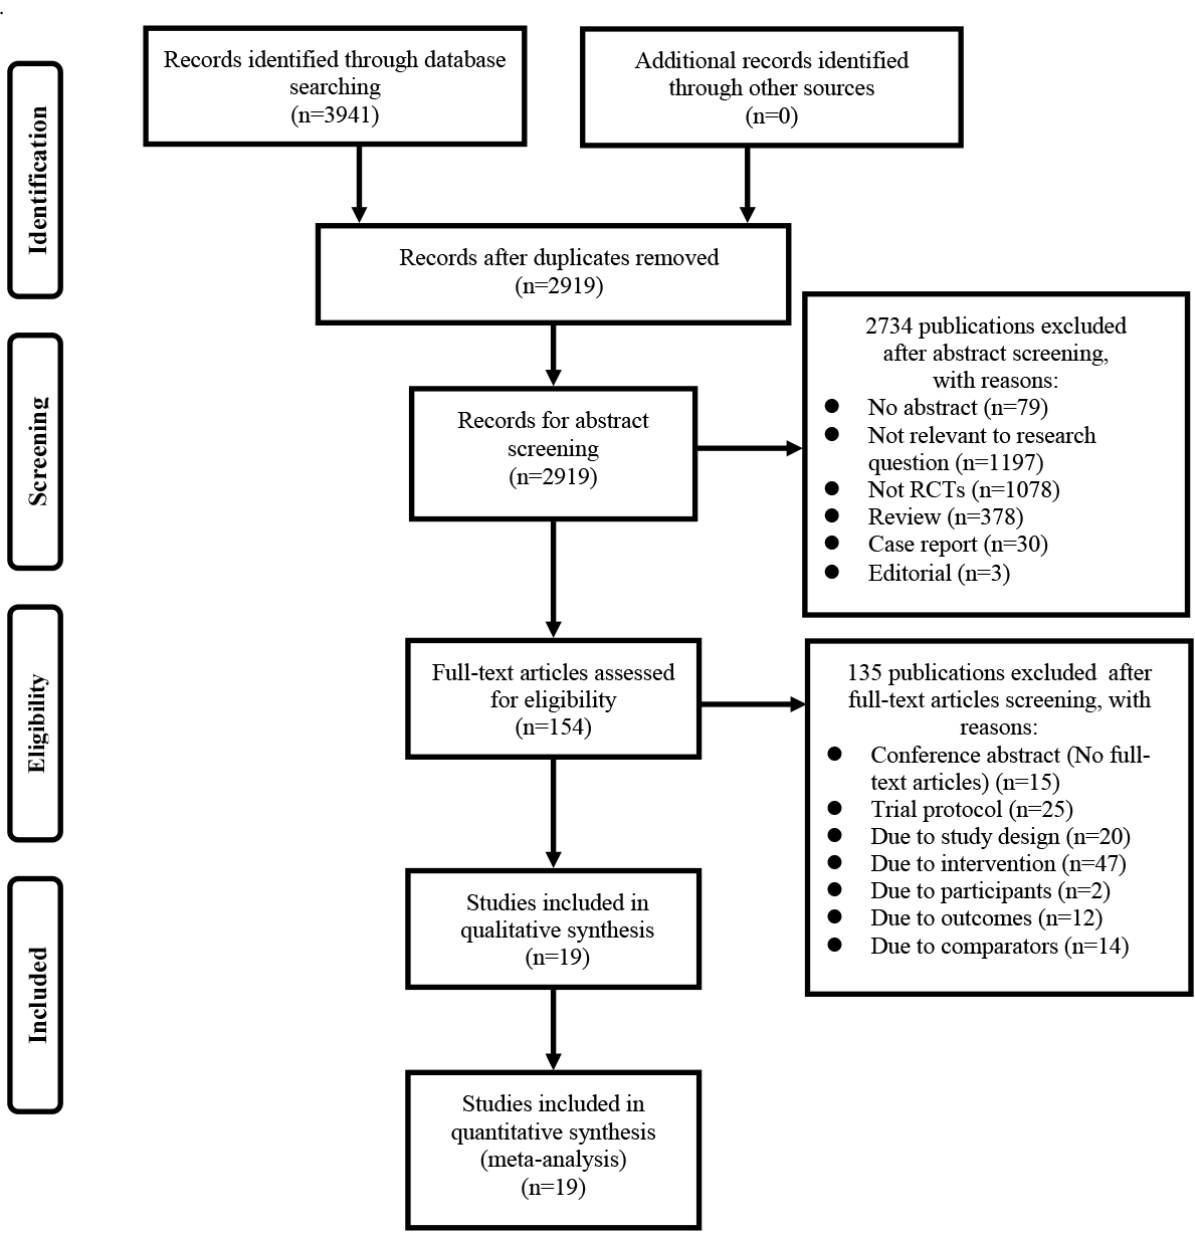
Figure 1. Preferred Reporting Items for Systematic Reviews and Meta-Analyses chart showing study selection process. RCT: randomized controlled